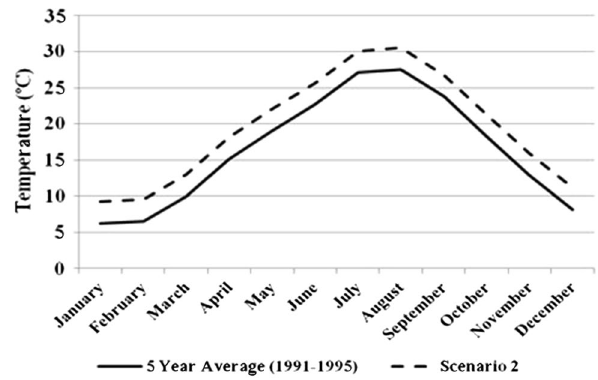
Fig. 6 Plot of correlation between observed and simulated discharges at Kawakami station (m 3 /s)